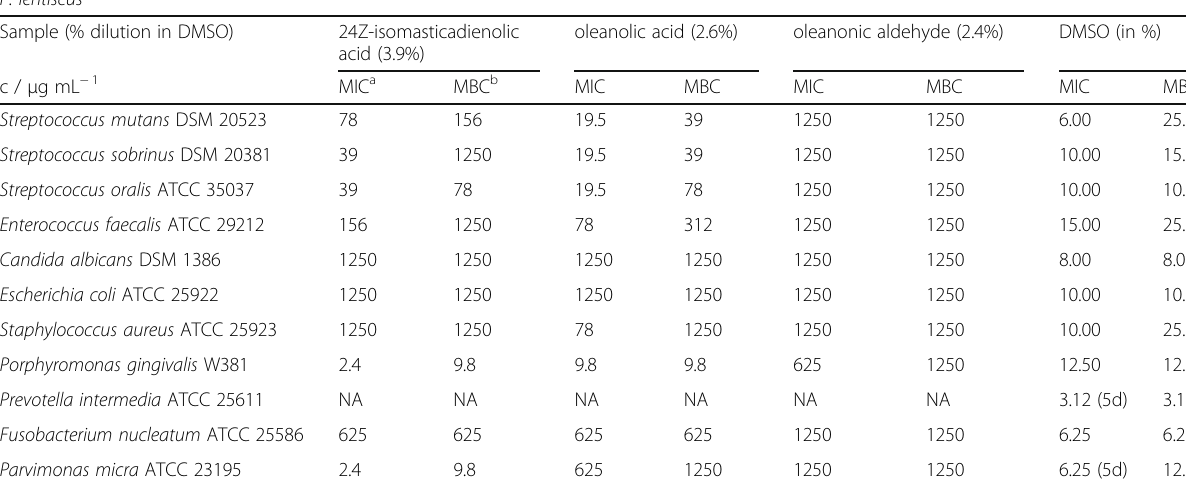
Table 2 Antimicrobial activity in μ g mL -1 of compounds from P. lentiscus P. lentiscus Sample (% dilution in